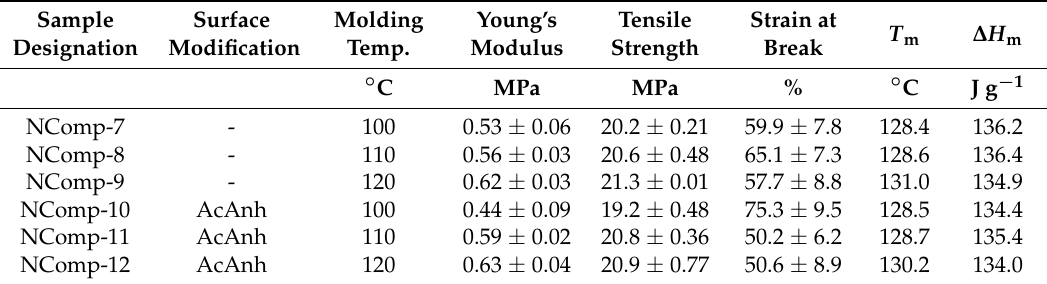
Table 2. Mechanical and thermal properties of CNC/LLDPE nanocomposites as a function of molding temperature and CNC surface modification. In all cases, the mass share of CNCs was 5 wt